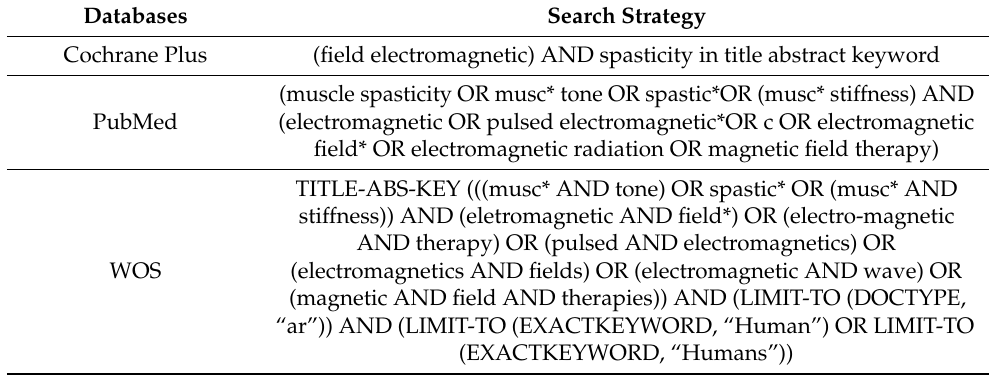
Table 1. Search combinations.